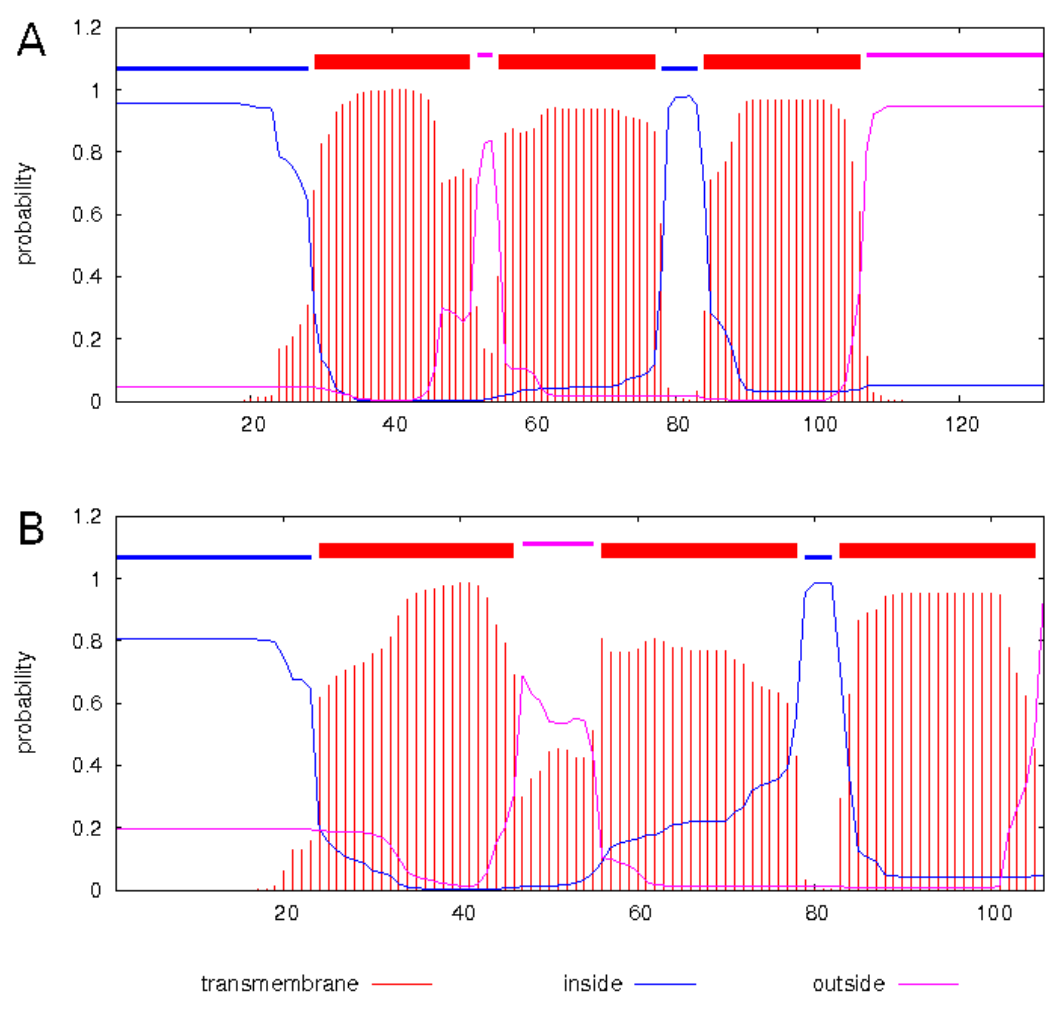
Figure 7. Transmembrane domains of the proposed nuORF product of ( A ) Alongshan virus strain Miass527, ( B ) Jingmen tick virus strain SY84. The analysis was done using TMHMM Server v. 2.0 program